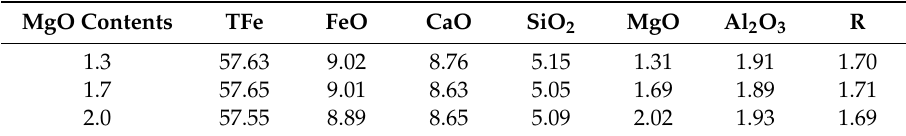
Table 1. Chemical composition of sinter [%].